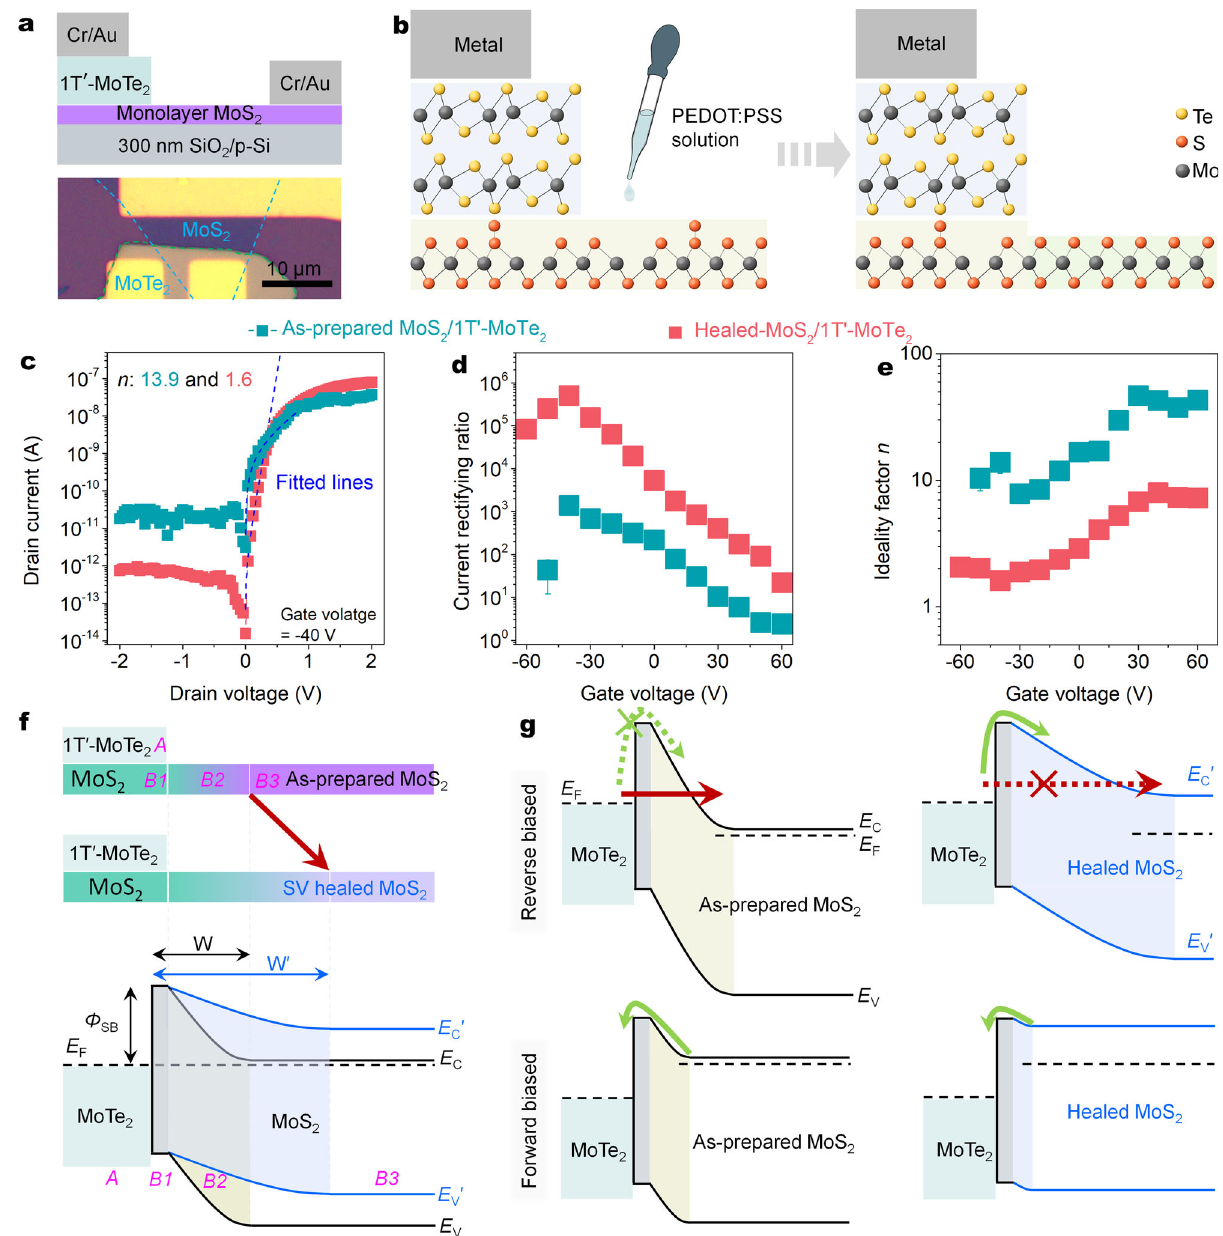
Fig. 3 Giant optimization of the Schottky junction through thickening the Schottky barrier width. a Schematic diagram (top) and optical micrograph (bottom) of 1T ′ -MoTe 2 /MoS 2 Schottky junctions in which the monolayer MoS 2 serves as the transport channel, p-Si is the control gate, SiO 2 layer is the gate dielectric, the 1T ′ -MoTe 2 is the bias drain electrode, and the Cr/Au is grounded. b Schematic diagram of the atomic structure of the 1T ′ -MoTe 2 /MoS 2 Schottky junctions before and after the SVSH. c Output curves in logarithmic scales of the 1T ′ -MoTe 2 /MoS 2 Schottky junctions before and after the SVSH. d , e Gate-dependent current rectifying ratios ( d ) and ideality factors ( e ) extracted from Supplementary Fig. 8 before and after the SVSH. f Device schematic diagrams (top) and band structure diagrams (bottom) before and after the SVSH. The E F , E C , and E V are Fermi level, conduction band, and valence band, respectively. The A, B1, B2, and B3 regions refer to the metal, contacted MoS 2 , depletion exposed MoS 2 , and pure channel MoS 2 . The yellow and blue gradient areas mean the depletion regions of the Schottky junctions. It should be noted that to simplify the band structure, the tunneling barriers originated from the vdWs gap between 1T ′ -MoTe 2 and MoS 2 are intentionally removed in the whole manuscript. g Band structure diagrams of the two- state devices at forward and reverse biased voltages. The green and red arrows (solid/dashed: main/almost-impossible style) indicate the thermionic emission current and thermally assisted tunneling current, respectively. The movement direction of an electron during reverse (forward) biased voltage is from the MoTe 2 to the MoS 2 (MoS 2 to MoTe 2